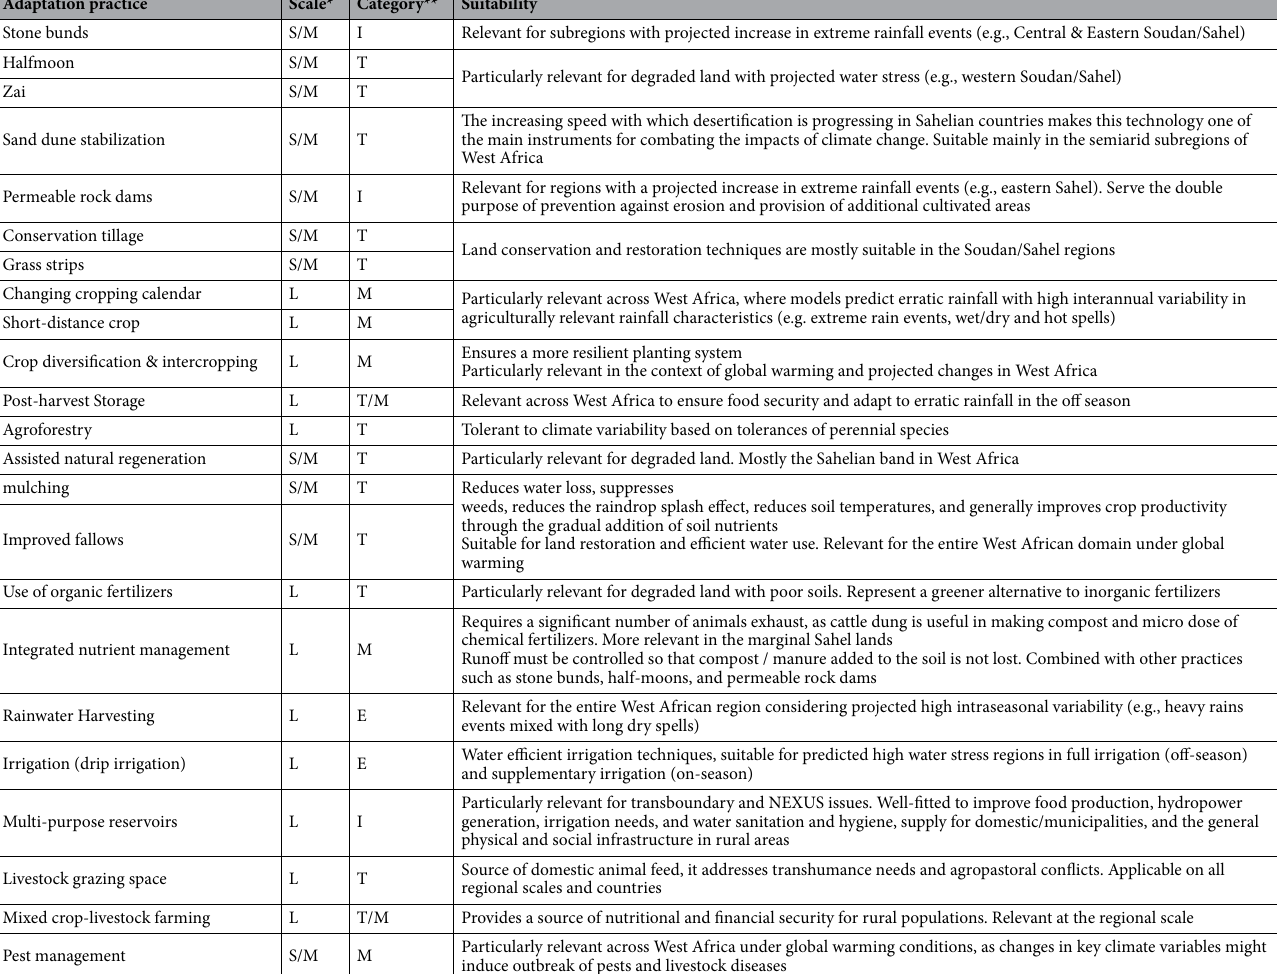
Table 1. List of adaptation practices in crops and water resources management. *Scale: S small, M medium, L large. **Category: T technical, M management, I